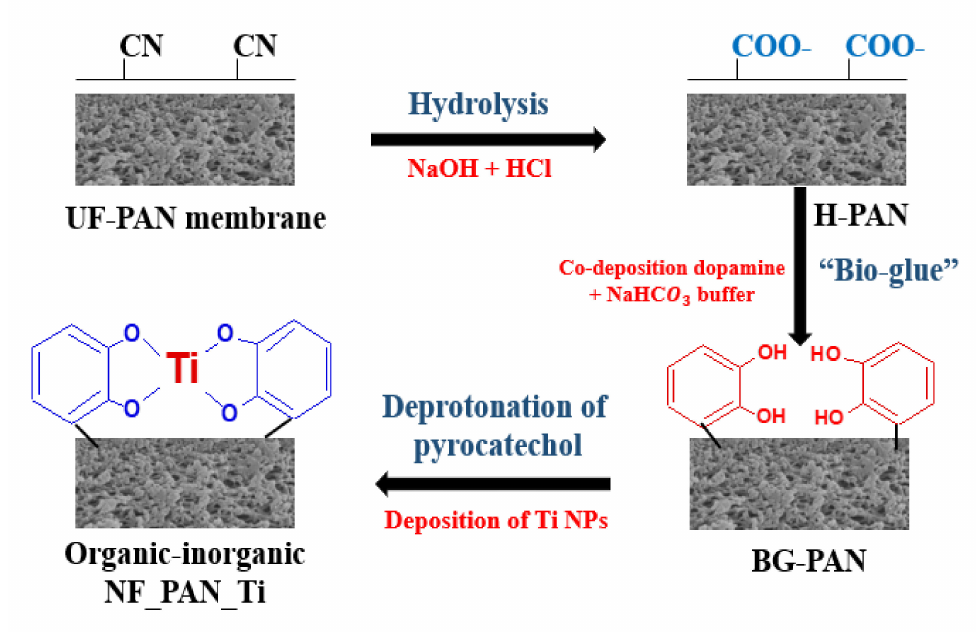
Figure 3. Steps of novel organic-inorganic nanofiltration membrane NF_PAN_Ti